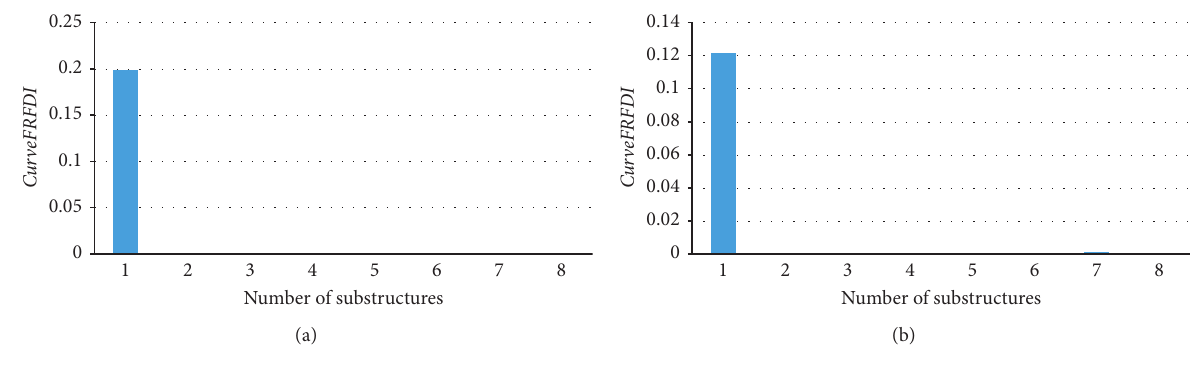
Figure 30: CurveFRFDI values of LVDT-measured data for (a) case Dam50_1F and (b) case